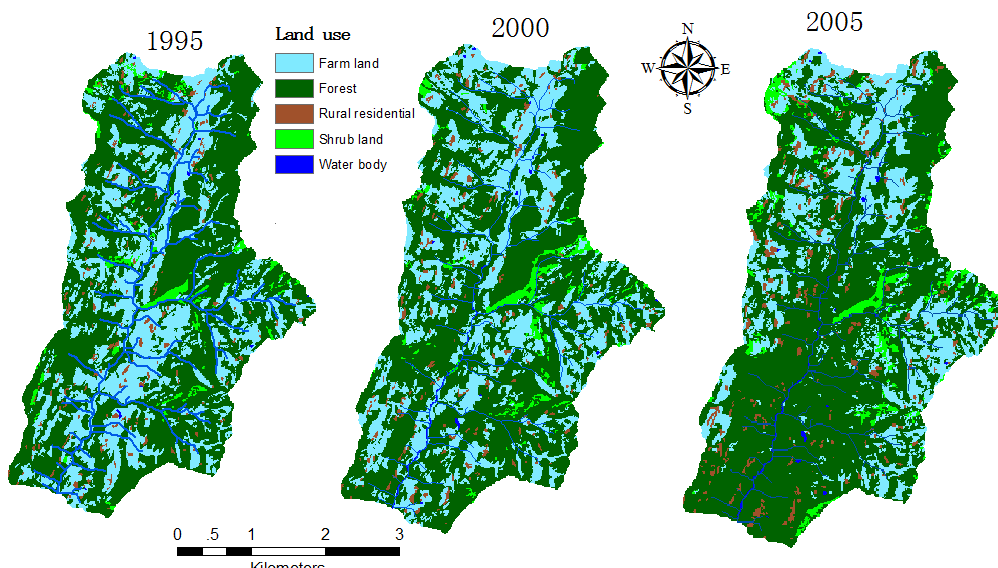
Figure 2. Land use change in the study watershed for 1995, 2000, and